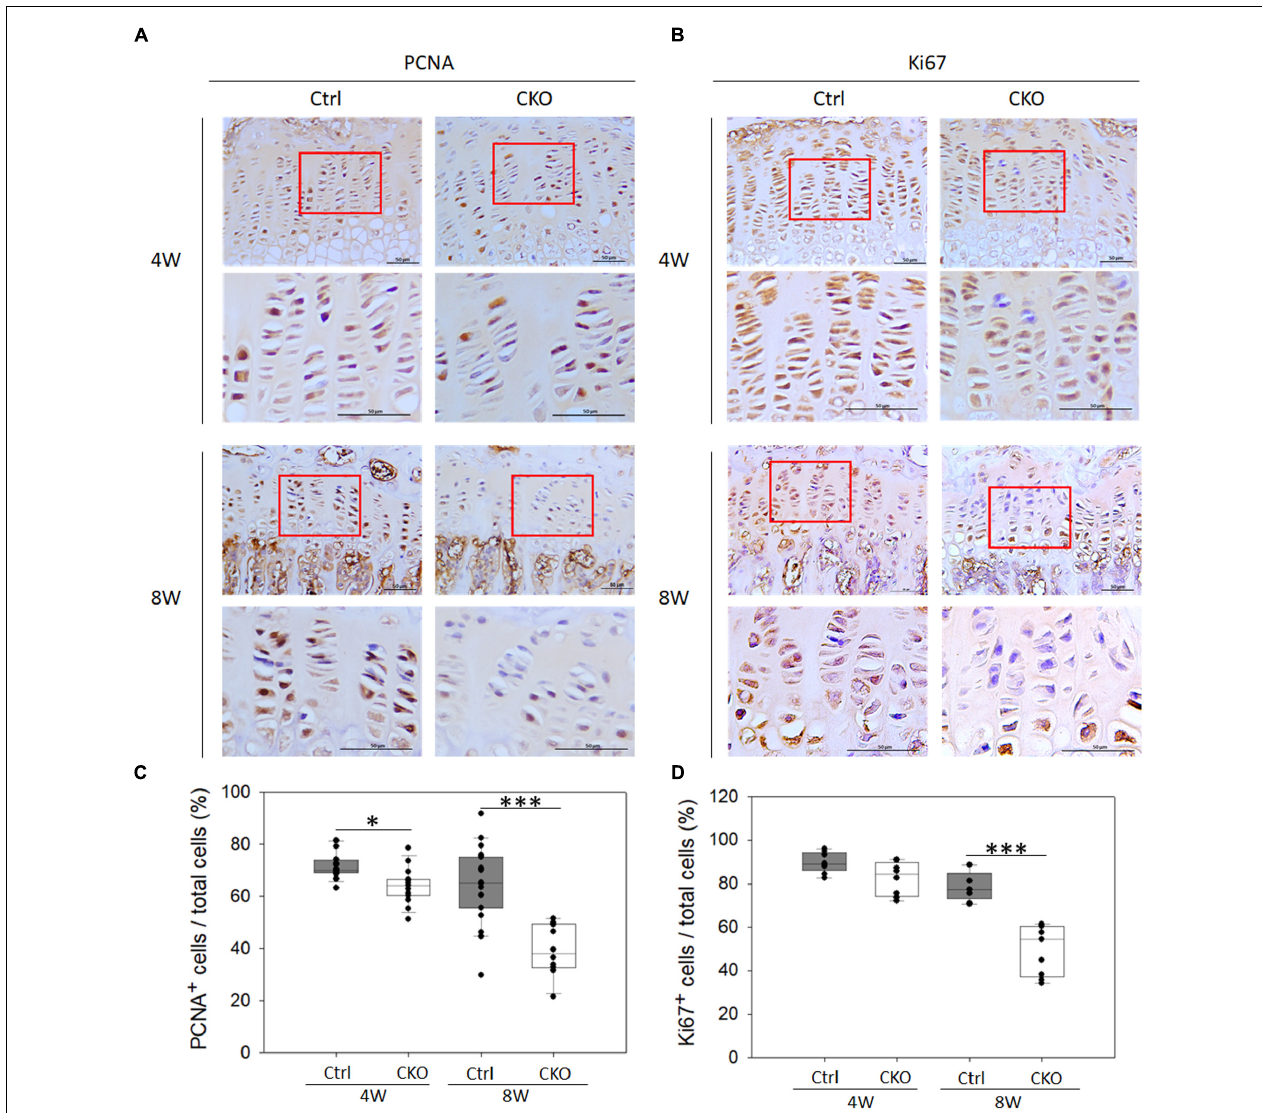
FIGURE 5 | Effects of chondrocyte-specific GPER-1 knockout (CKO) on chondrocyte proliferation in tibia growth plates. (A,B) IHC staining of PCNA and Ki67 in tibial growth plates in 4- and 8-week-old female mice. Representative micrographs of growth plates at low and high magnification. Scale bars, 50 µ m. (C,D) Quantification of ratio of proliferative cells to total cells was shown as ratio of PCNA- and Ki67-positive cells to hematoxylin-stained cells (total cells). Each group, N = 5. ∗ P < 0.05, ∗∗∗ P <